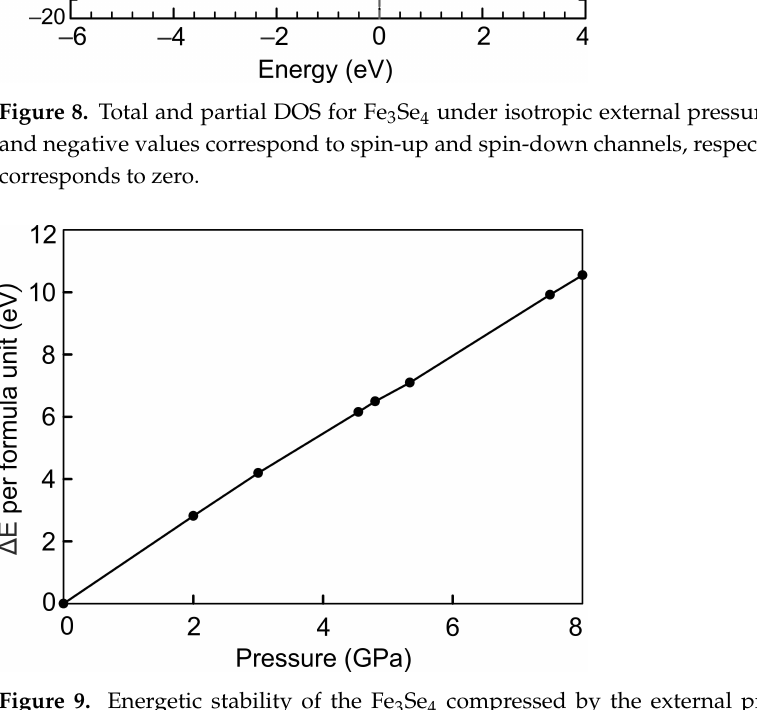
Figure 9. Energetic stability of the Fe 3 Se 4 compressed by the external pressure relative to the uncompressed structure, ∆ E in eV per Fe 3 Se 4 formula